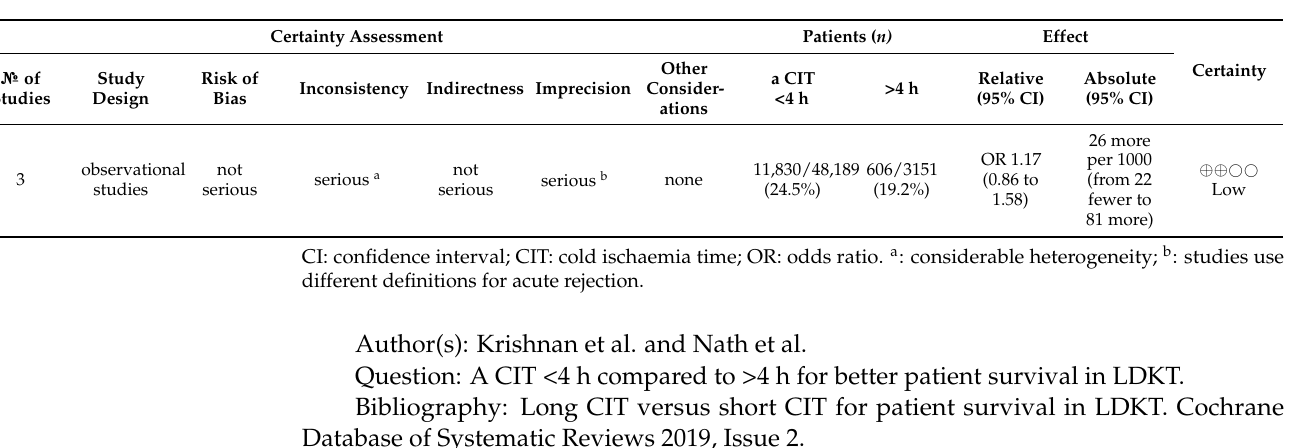
Table A3. Summary of findings with the level of evidence estimated by the Grade-tool for acute rejection.